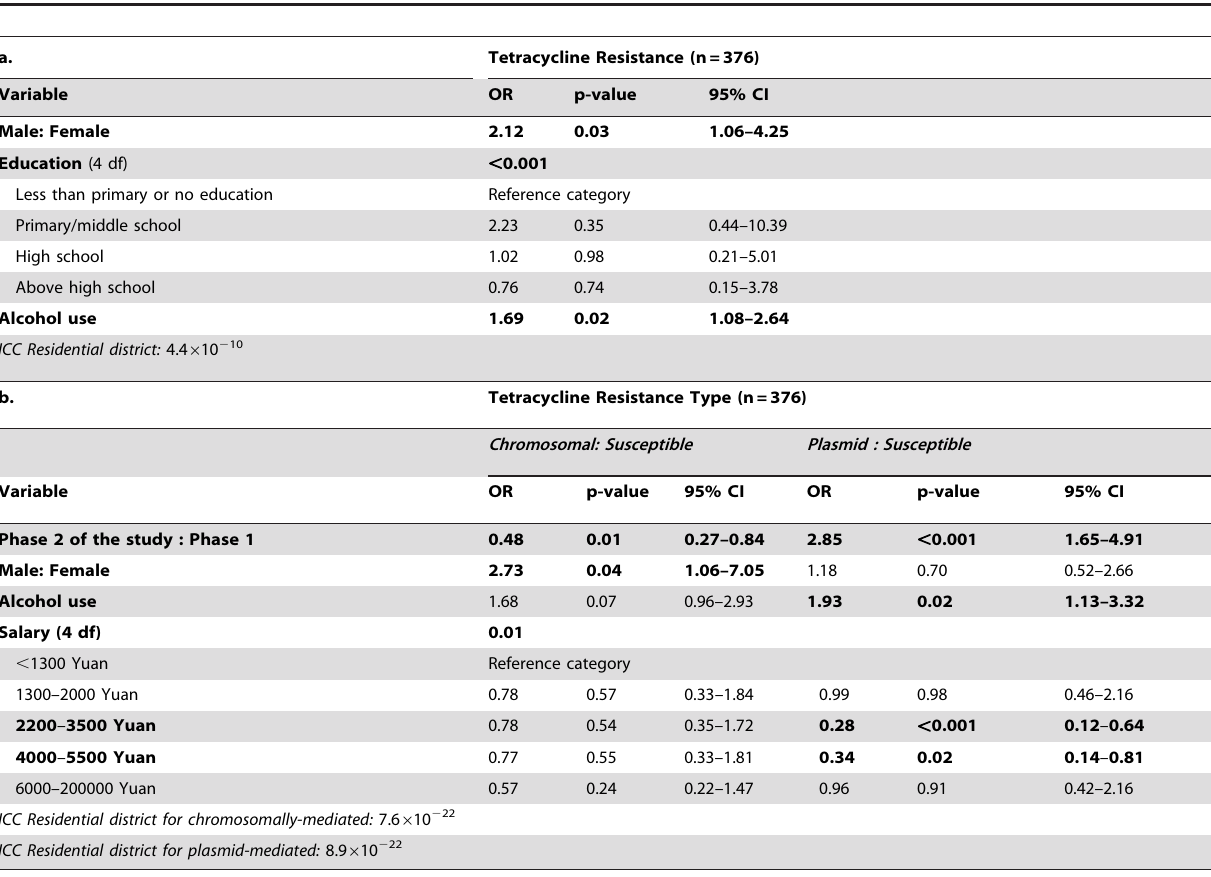
Table 6. Results of multivariable analysis for overall and type of tetracycline resistance (resistance (odds ratios (OR) and 95% confidence intervals (95%